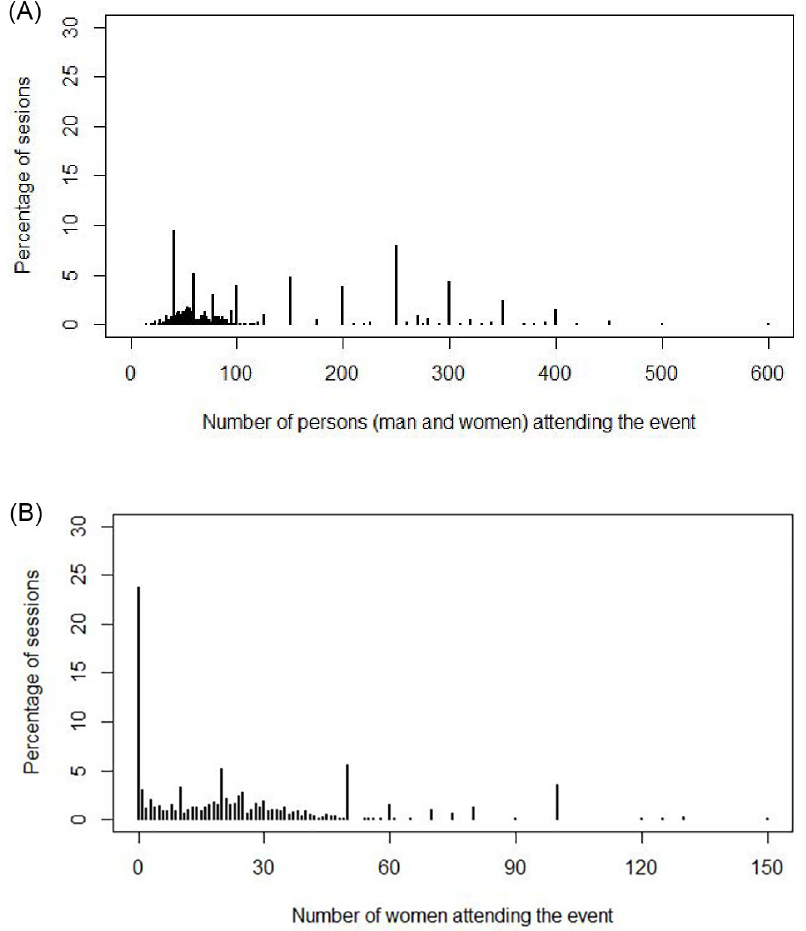
Fig 3. (A) The distribution of number of persons (males and females) and (B) the distribution of number of females attending training